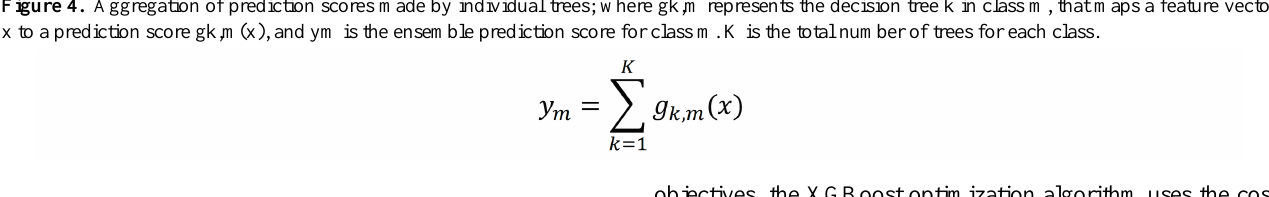
Figure 4. Aggregation of prediction scores made by individual trees; where gk,m represents the decision tree k in class m, that maps a feature vector x to a prediction score gk,m(x), and ym is the ensemble prediction score for class m. K is the total number of trees for each class.